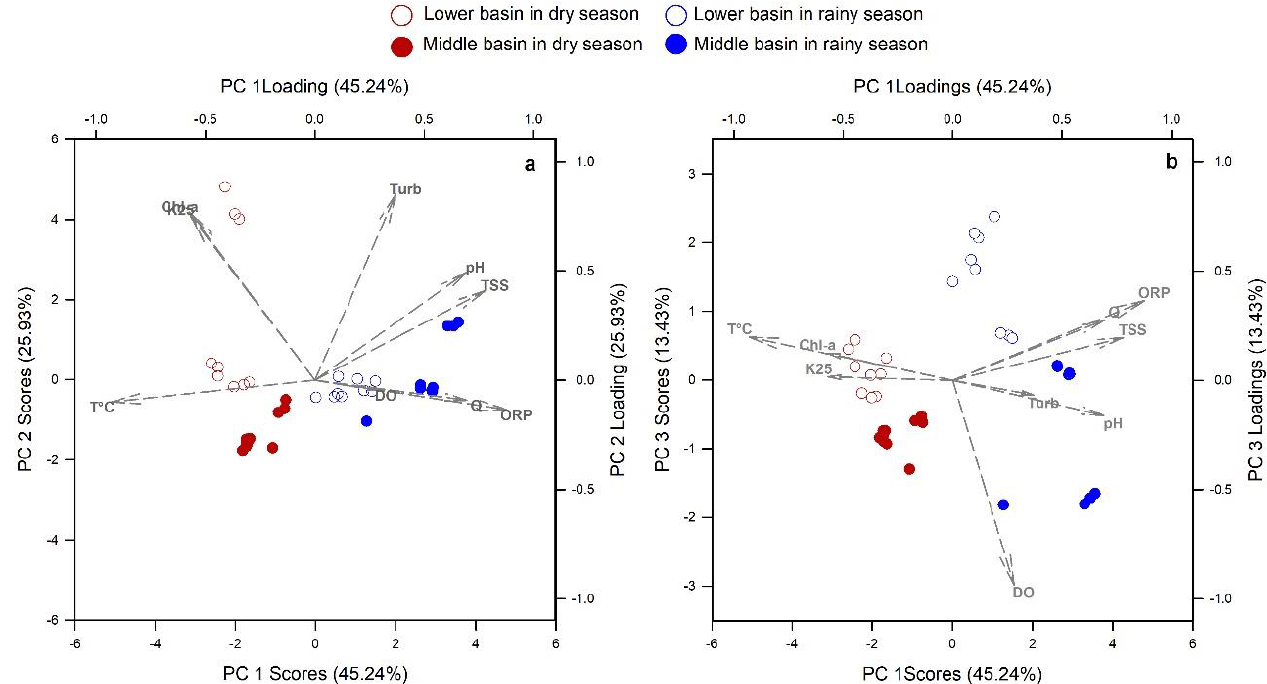
Figure 2. Spatial and seasonal water quality variation in the Usumacinta River main channel and major tributaries, as displayed using PCA: ( a ) Representation of PC 1 against PC 2 and ( b ) representation of PC 1 against PC 3. The percentages indicate the explained variance of the PCs.